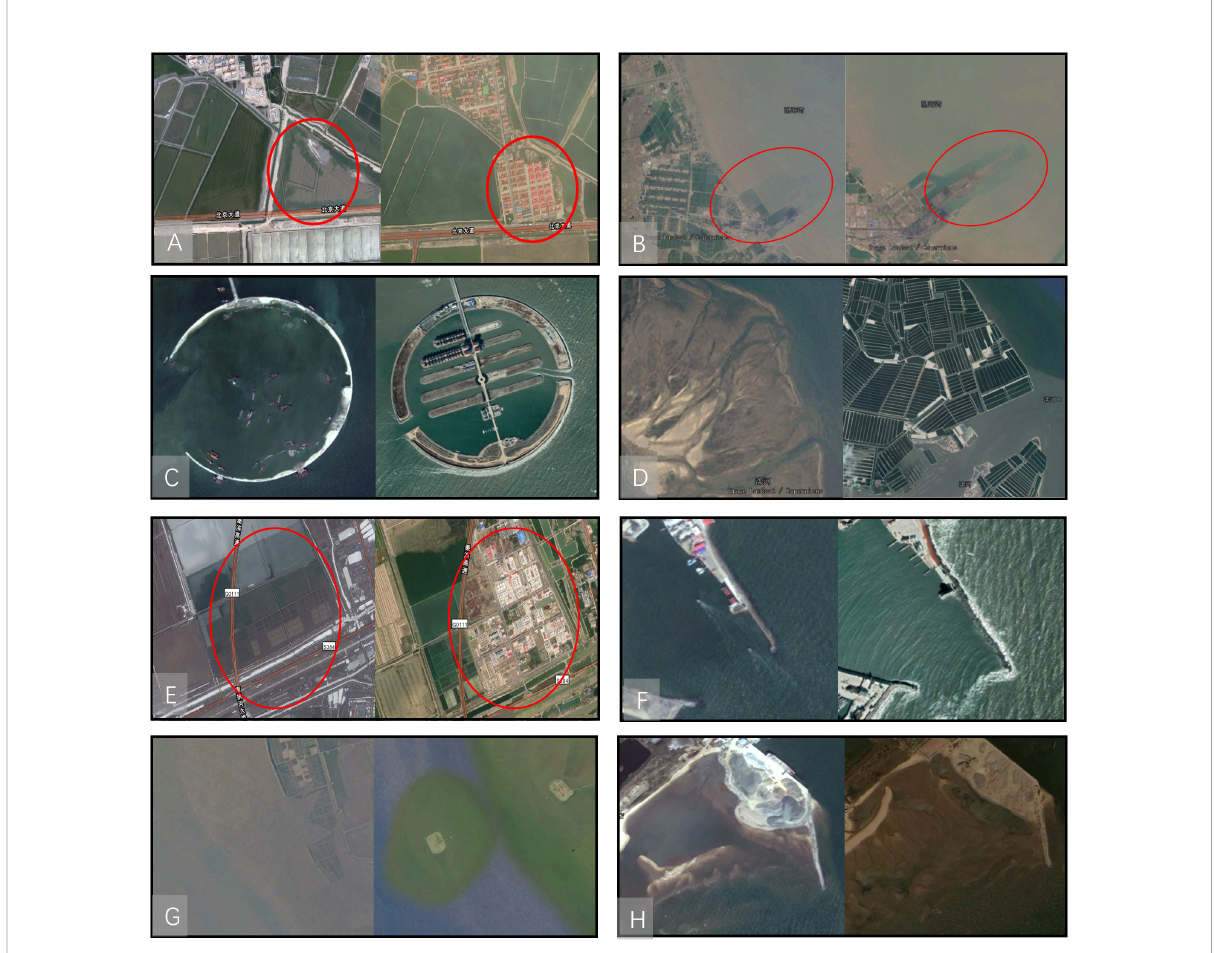
FIGURE 8 Typical types of human expansion in the coastal zone. (A) urban expansion in Tangshan, (B) port construction in Huanghua, (C) tourism development in Nandaihe, (D) mariculture in Luanhe River estuary, (E) industrial parks in Qinhuangdao, (F) coastal engineering in Qinhuangdao, (G) resource exploitation in Caofeidian, (H) repair engineering in